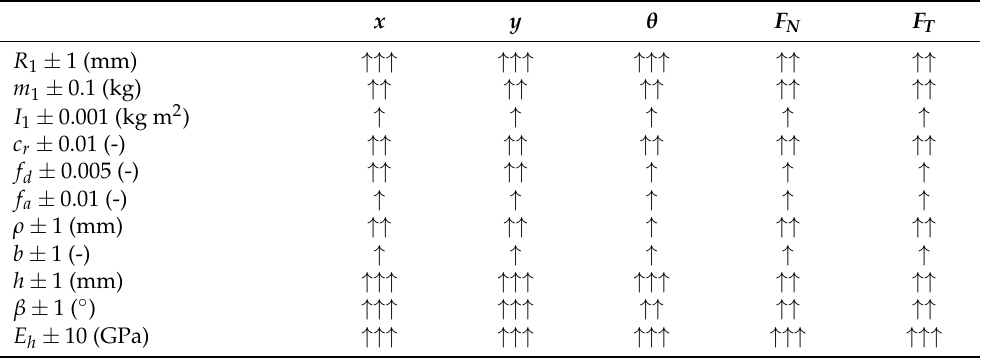
Table 5. Parametric analysis for the time-stepping Moreau’s method. One arrow (low influence), two arrows (medium influence), three arrows (high